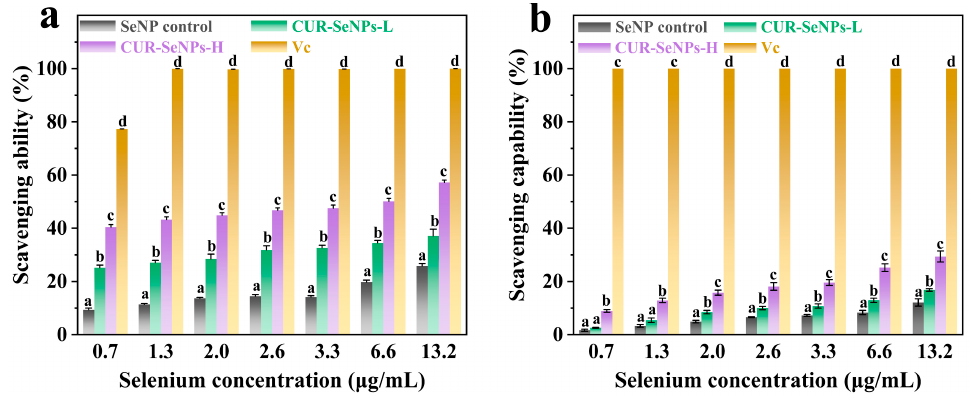
Figure 5. Reactivity of CUR-SeNPs with ( a ) hydroxyl radicals and ( b ) superoxide anion radicals (different letters in the same concentration group indicate significant differences between samples, p < 0.05).